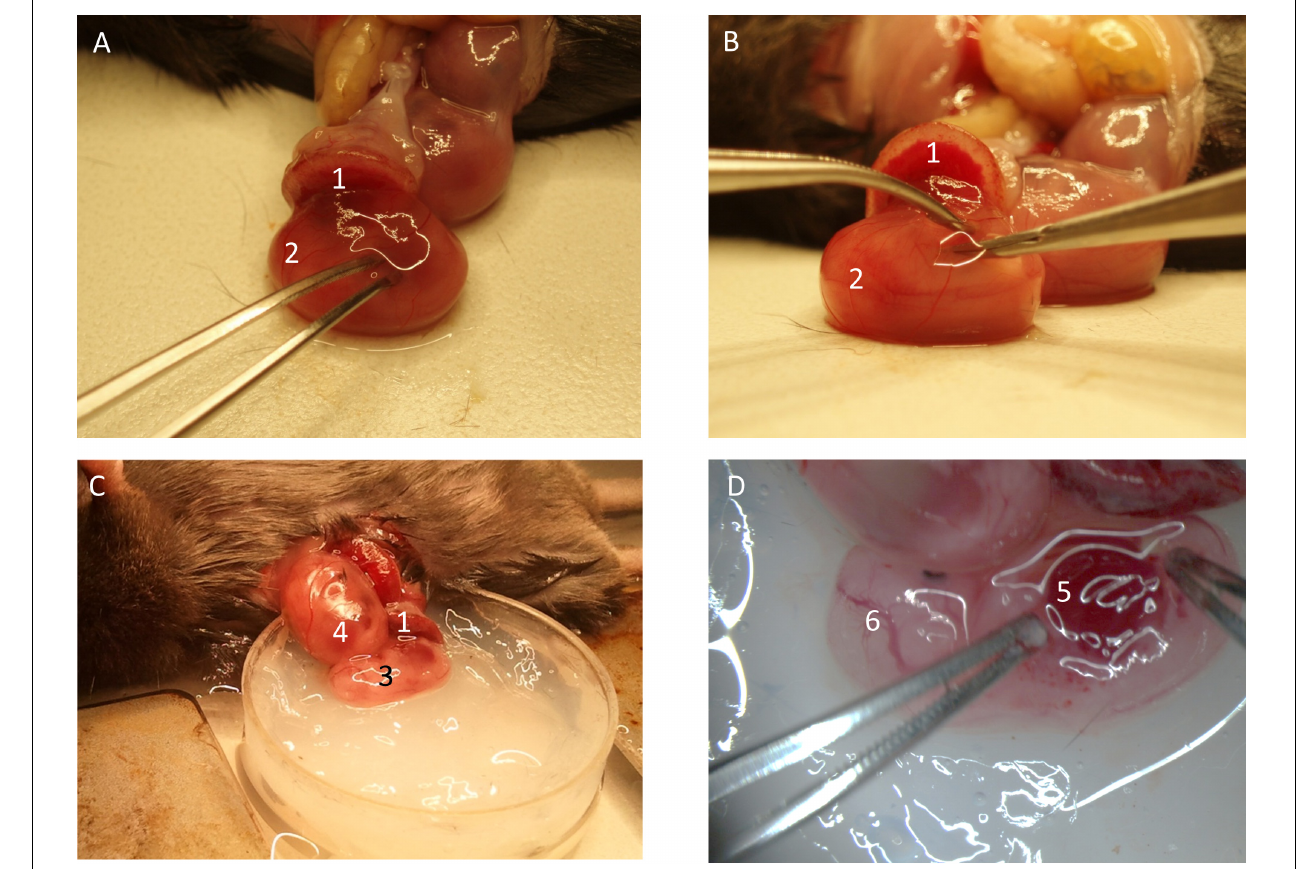
FIGURE 3 | Preparation of fetal liver. (A) The yolk-sac is carefully opened. (B) The fetus is removed from the yolk-sac and (C) placed into the imaging-dish. (D) The liver region is prepared for imaging. (1) Placenta. (2) Fetus inside yolk-sac being mobilized. (3) Fetus without yolk-sac. (4) Fetus within yolk-sac. (5) Fetal liver. (6) Cranial region of